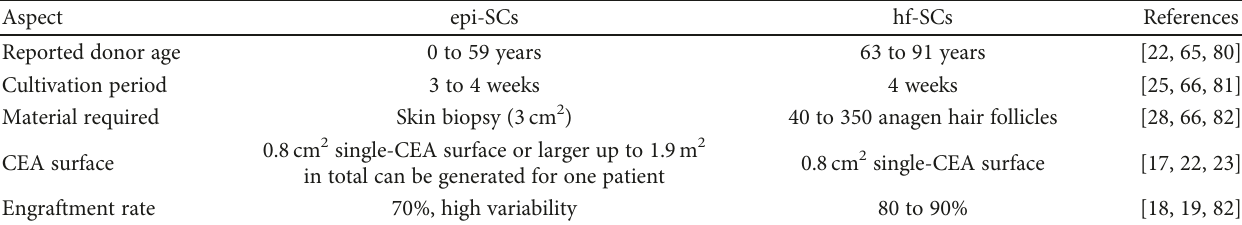
Table 1: Comparison between epi-SC- and hf-SC-derived